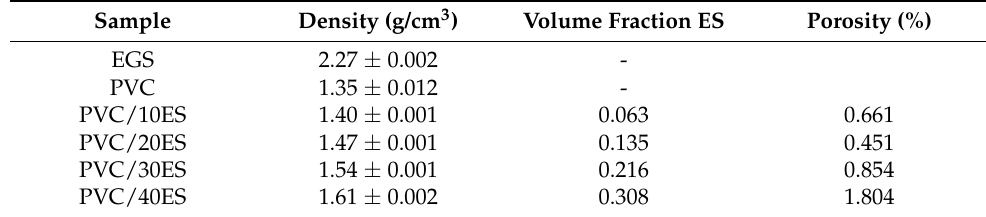
Table 2. Results of density and porosity calculation for PVC, ES, and PVC/ES